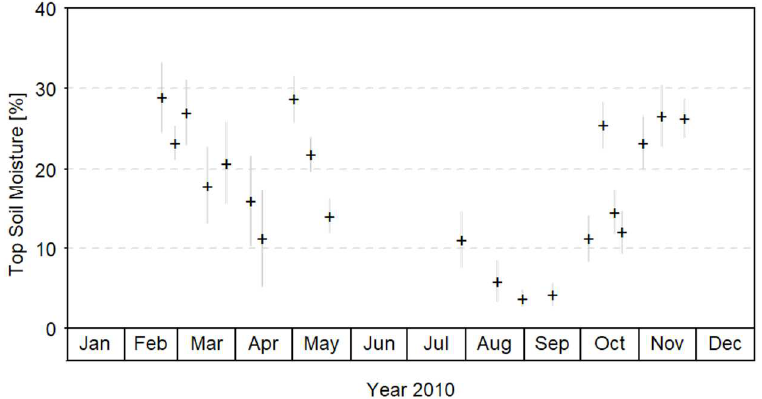
Figure 3. Time course of topsoil moisture (mean (black dots) and standard deviation (in gray) values) collected on the monitored plots with bare soil conditions.